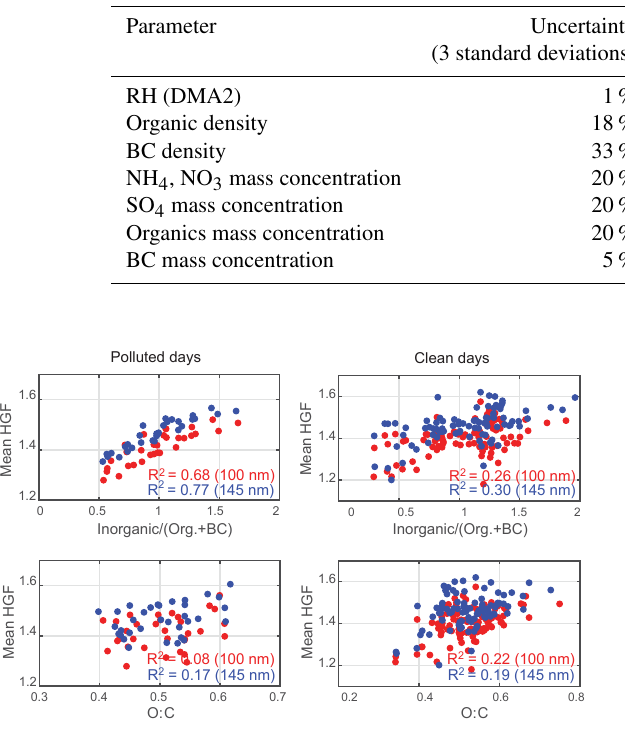
Figure 7. The correlation between the mean HGFs of accumulation mode particles (100nm, 145nm in size) and the contribution of dif- ferent species in the particle phase as well as the O : C of the organic materials during polluted days and clean